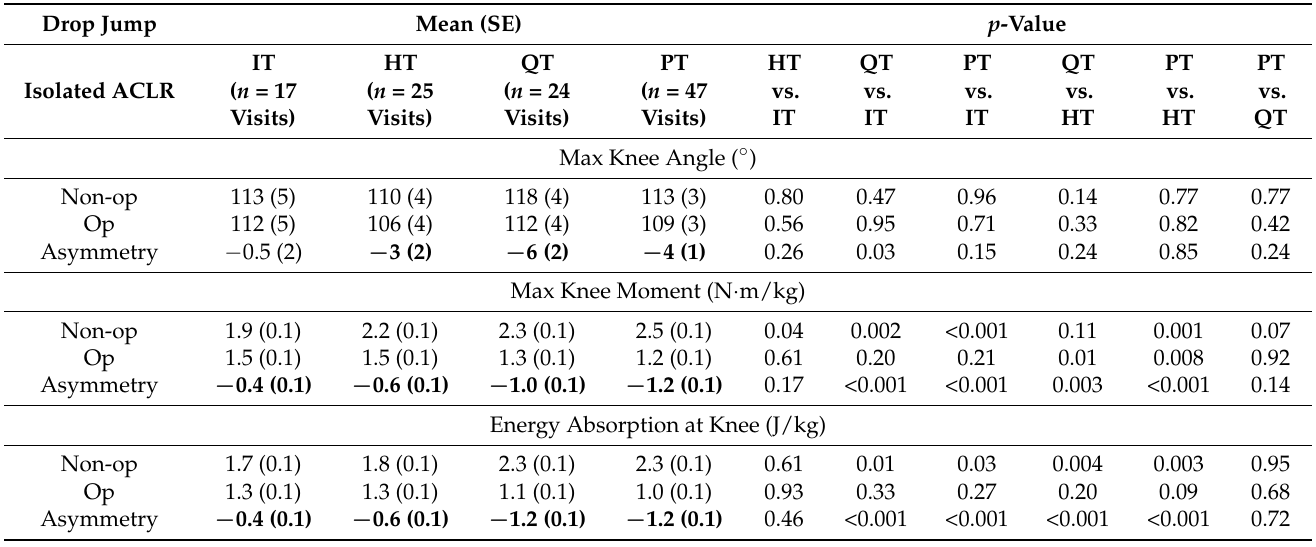
Results are presented as model predicted mean (SE) adjusting for sex, age, and time since surgery. Bold indicates significant differ- ence between sides (asymmetry) within each group at p < 0.05. IT: iliotibial band; HT: hamstring tendon; QT: quadriceps tendon; PT: patellar